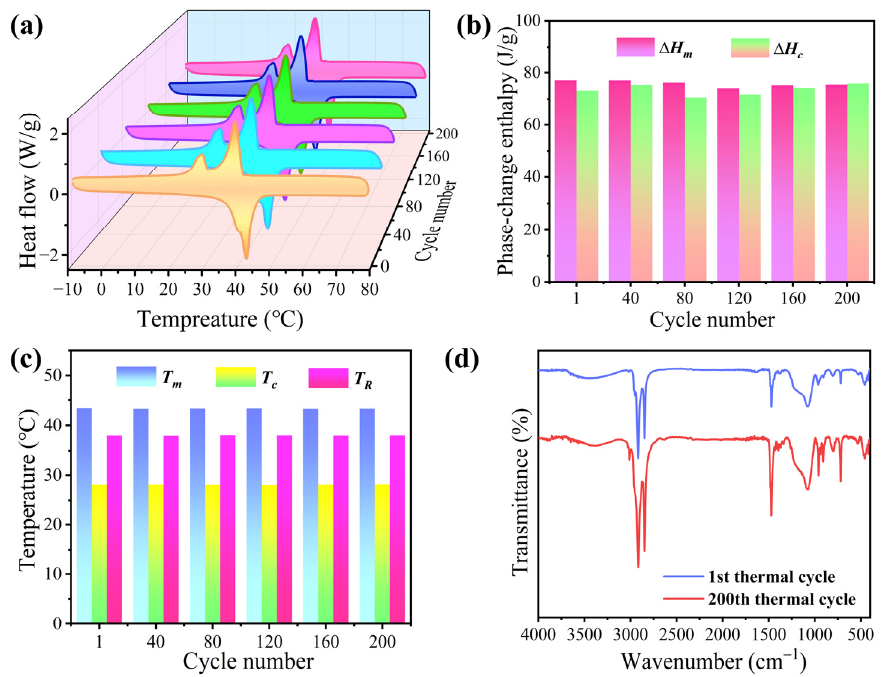
Figure 11. ( a ) DSC thermograms, ( b ) phase-change enthalpies, and ( c ) phase-change temperatures of BiOI-MEPCM (1:1) at every 40 heating-cooling thermal cycles. ( d ) FTIR spectra of BiOI-MEPCM (1:1) before and after thermal cycles.